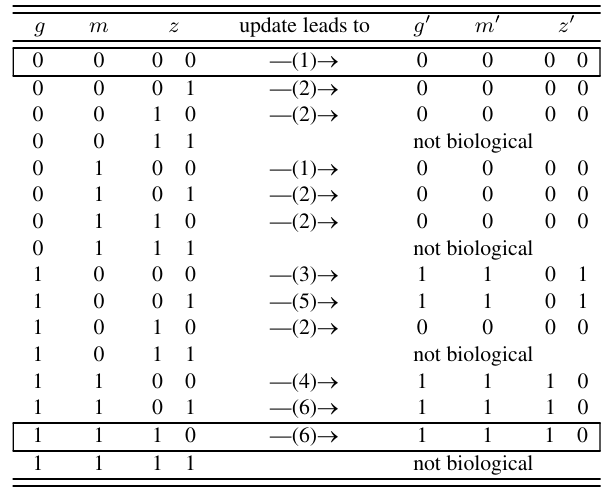
FIGURE 3 | Simplified state space of the leaf epidermis gene regulatory network where the variables g , m , z have an indirect biological meaning, seeAppendix. The number in brackets gives the corresponding row of TableA4 in Appendix.The state z is represented by two internal Boolean variables, as a side effect there are states without biological counter-part.The framed rows are the two fixed points.